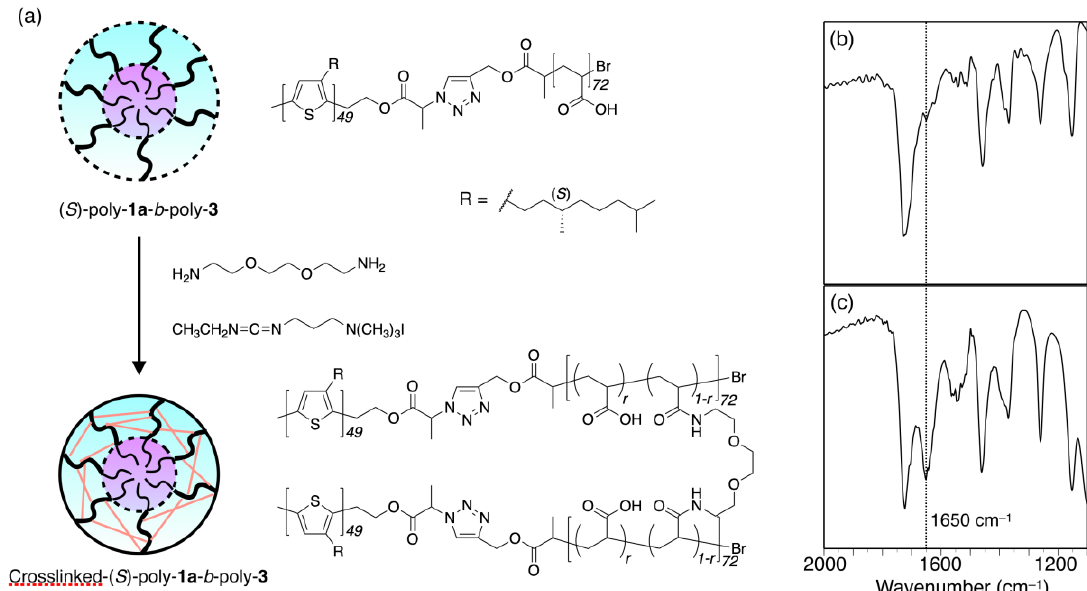
Figure 4. ( a ) Schematic illustration of shell crosslinking of micelles comprising ( S )-poly- 1a - b -poly- 3 and ( b , c ) IR spectra of ( b ) (( S )-poly- 1a - b -poly- 3 and ( c ) crosslinked-( S )-poly- 1a - b -poly- 3 at rt.